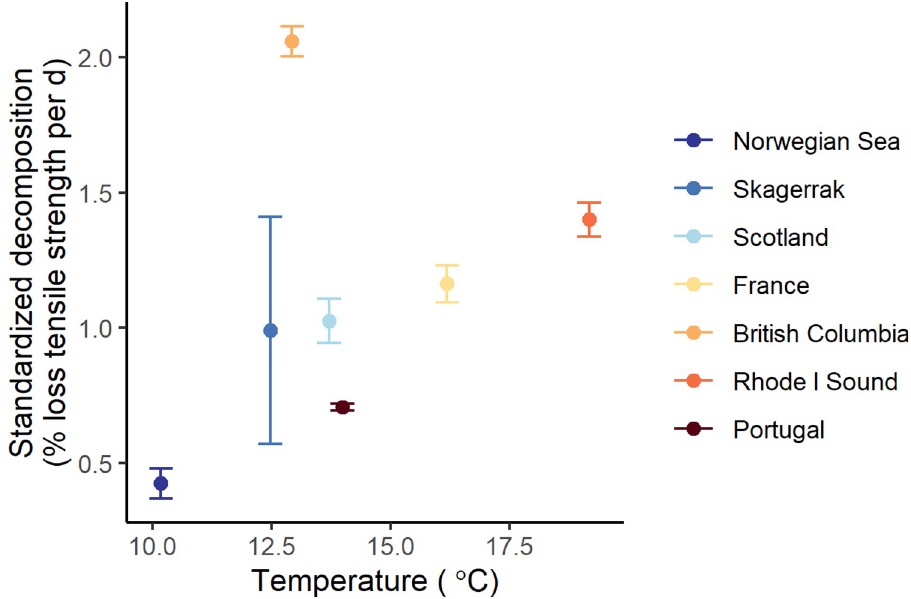
Fig 4. Carbon processing capacity at study sites. Relationship between the carbon processing capacity of the temperate reef ecosystem and temperature on the seafloor over the deployment period. Decomposition is loss of tensile strength per day of cotton strips at each study region (average and SD over sites) (Data D in S1 Data).